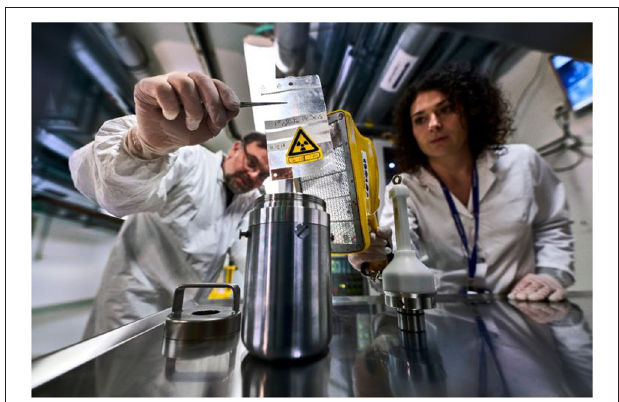
FIGURE 4 | Dose rate measurement on the first collection of Tb-155 at CERN-MEDICIS.